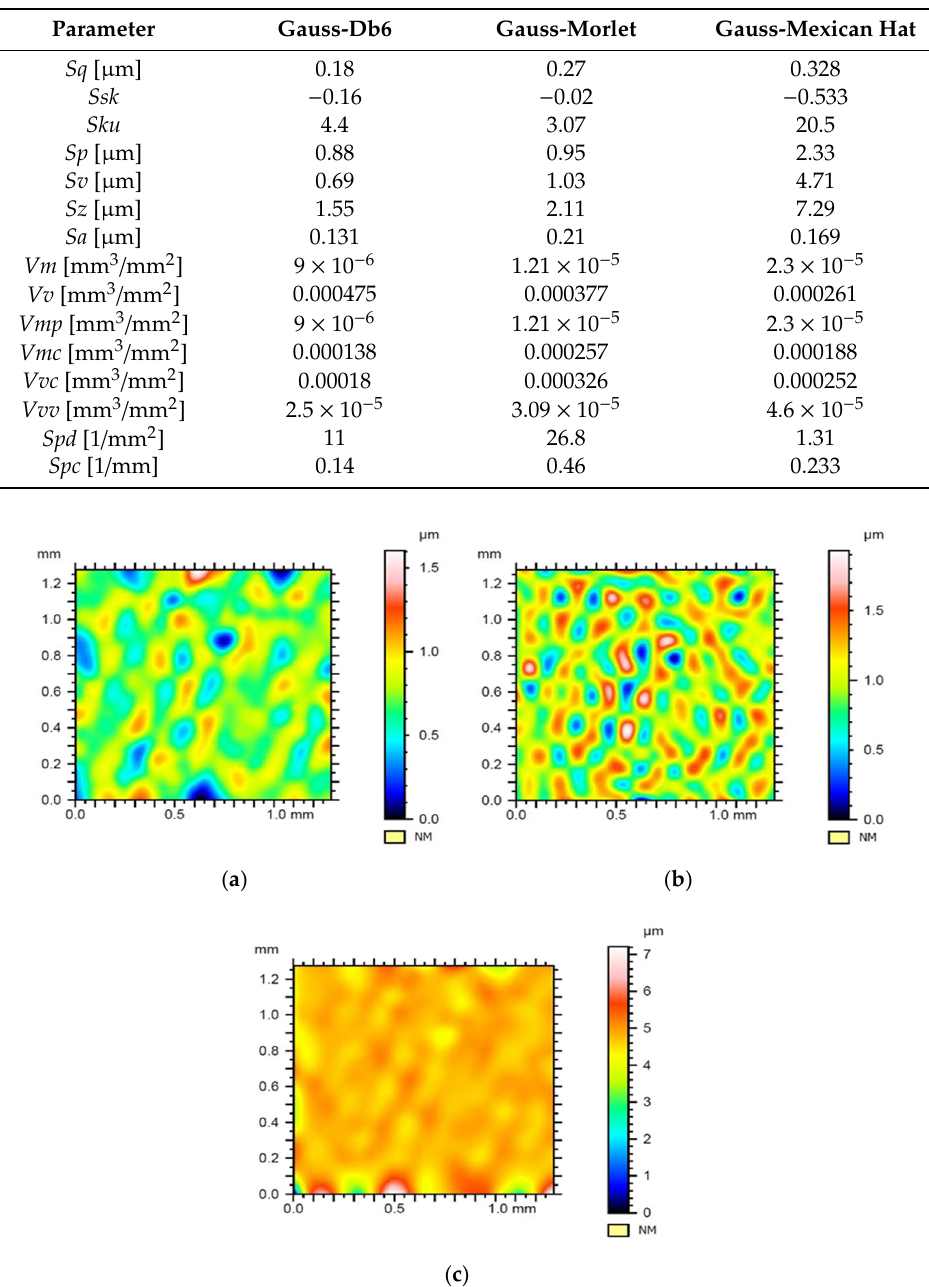
Table 3. Selected spatial parameters, calculated for surfaces shown in Figure 19.